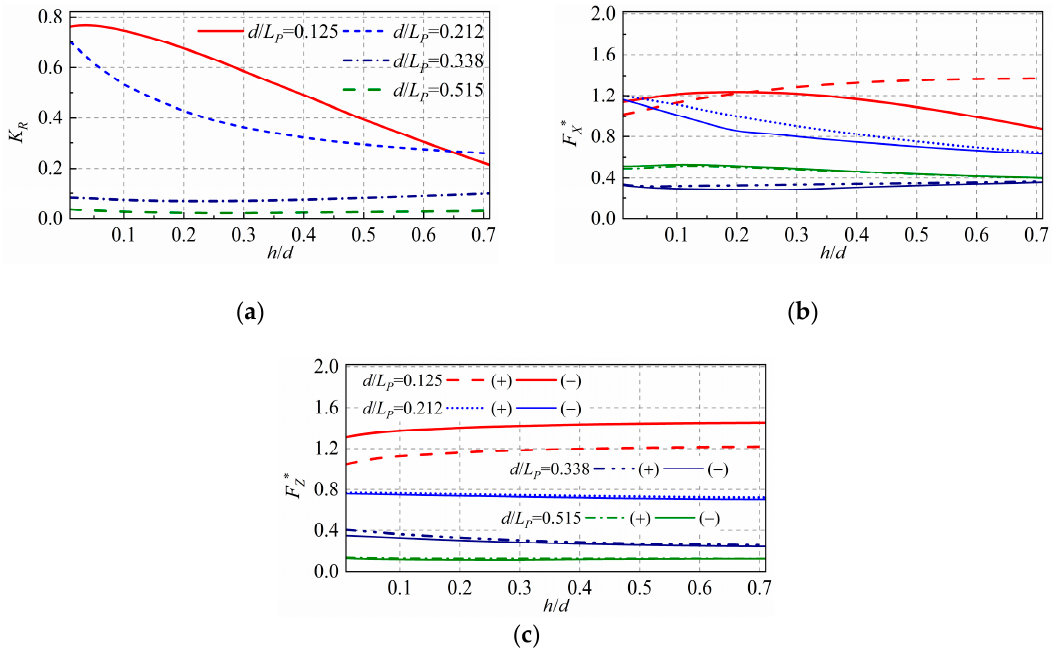
Figure 10. Variations of reflection coe ffi cients and wave forces about dimensionless structural height h / d with di ff erent peak wave length ( a ) reflection coe ffi cient, ( b ) horizontal force and ( c ) vertical